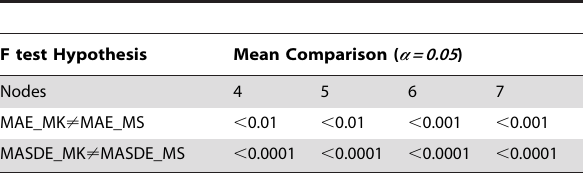
Table 2. Mean comparison from ANOVA between MKRBF and MSRBF (All